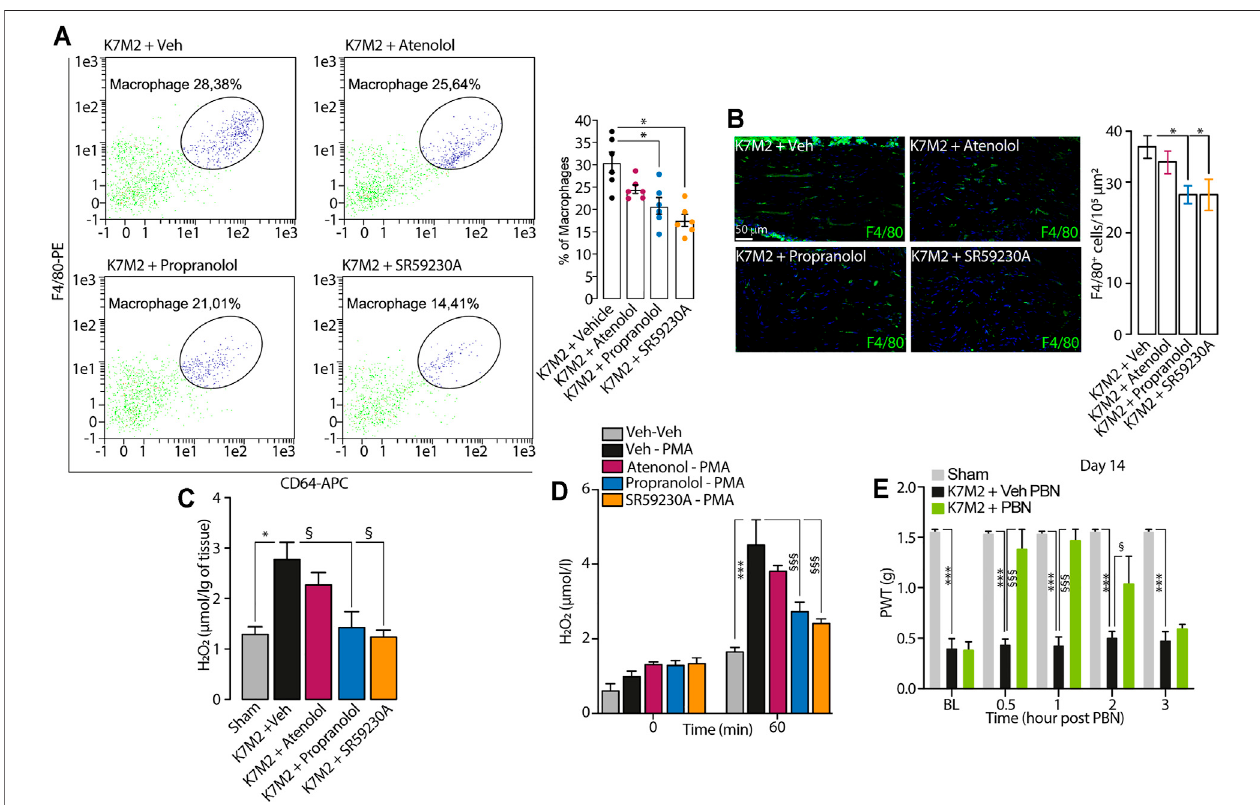
FIGURE 3 | β 2-and β 3-AR antagonists reduce neuroin fl ammation in tibial nerve of K7M2 osteosarcoma-bearing mice (A) Representative fl ow cytometry analysis and relative quanti fi cation of F4/80 + /CD64 + macrophages (B) typical immuno fl uorescence images and pooled data of F4/80 + cells and (C) H 2 O 2 content in the tibial nerve after para-tibial K7M2 osteosarcoma cell inoculation or sham in BALB/c mice treated (daily, starting from day 10) with atenolol (10 mg/kg, i.p.) propranolol (10 mg/kg, i.p.), SR59230A (10 mg/kg, i.p.) or vehicle (Veh) (D) H 2 O 2 level in RAW 264.7 stimulated with PMA (16 μ M) in presence of SR59230A, propranolol, atenolol(all, 100 nM) orVeh (n (cid:2) 3independent experiments) (E) Mechanical allodynia at day 14 after para-tibial K7M2 osteosarcoma cell inoculation orsham in BALB/c mice treated with PBN (100 mg/kg, i.p.) or Veh. BL, baseline. PWT, paw withdrawal threshold. N (cid:2) 6 mice. * p < 0.05, *** p < 0.001 vs Sham, Veh-Veh; § p < 0.05, §§§ p < 0.001 vs K7M2 + Veh, Veh-PMA, K7M2 + Veh PBN. Data are presented as mean ± SEM. One-way (A – C) or two-way (D – E) ANOVA and Bonferroni post hoc